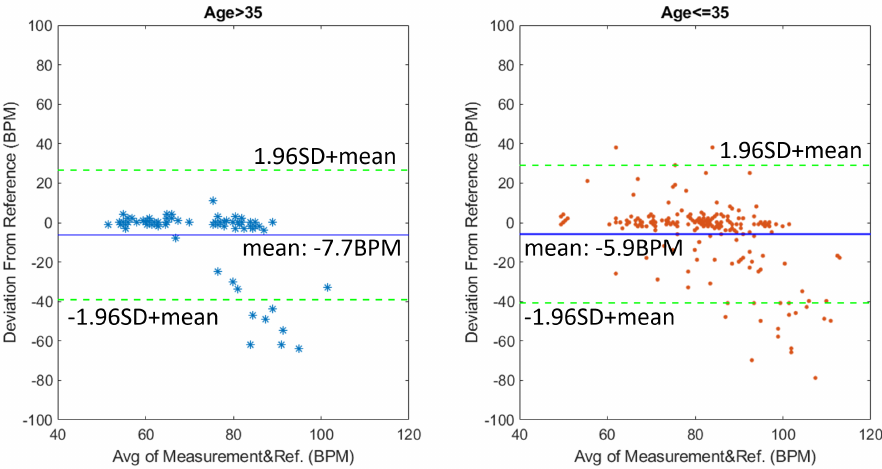
Figure 19. Bland-Altman plot for HR measurements within groups of: age > 35 ( left ) and age <= 35 ( right